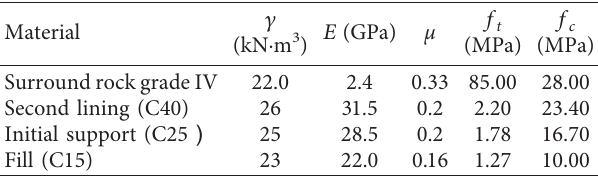
Figure 1: The location of the Hebai tunnel. Table 1: Physical and mechanical parameters.